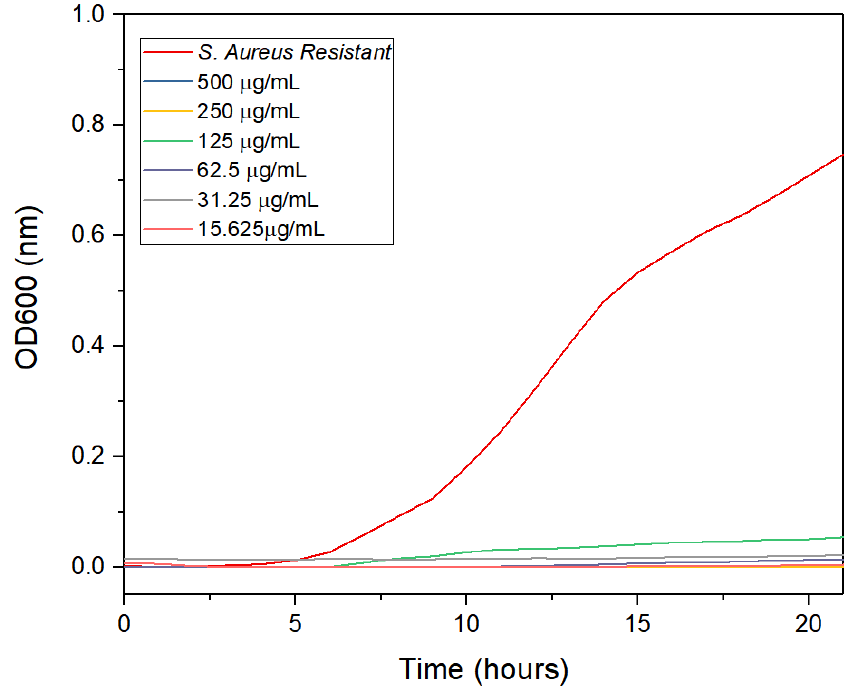
Antibiotics 2023 , 12 , x FOR PEER REVIEW Figure 13. Antimicrobial activity of the AgNPs synthesized with grapefruit peel extract at different times.